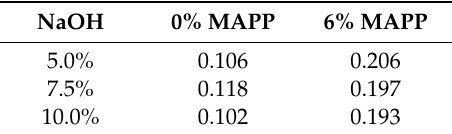
Table 7. Coupling factors obtained by solving a modified rule of mixtures for the tensile strength of the